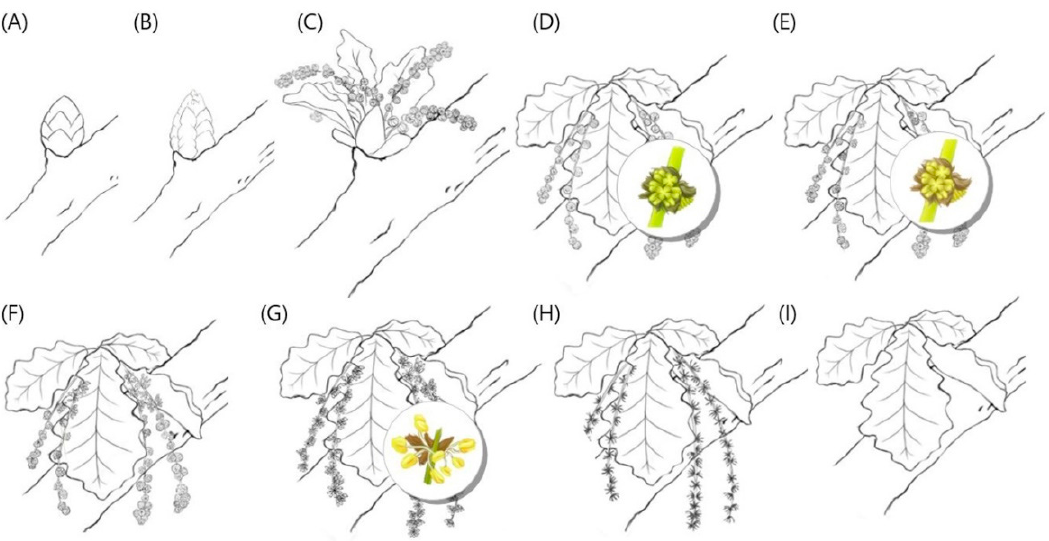
Figure 2. Schematic illustration of nine phenological stages from male flowers of Quercus (Fagaceae) in Korea. ( A ) Winter bud; ( B ) bud burst; ( C ) catkin development; ( D ) catkin elongation; ( E ) maturation of catkin; ( F ) start of flowering; ( G ) full flowering; ( H ) senescence; ( I ) catkin fall.